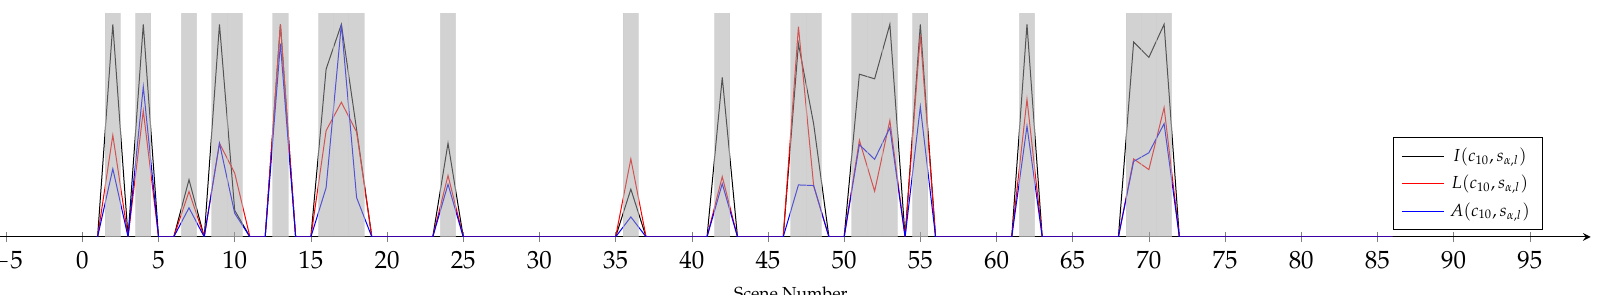
( a ) Selected scenes and feature values for the protagonist ( c 0 ) in scenes that are not selected by the first iteration.